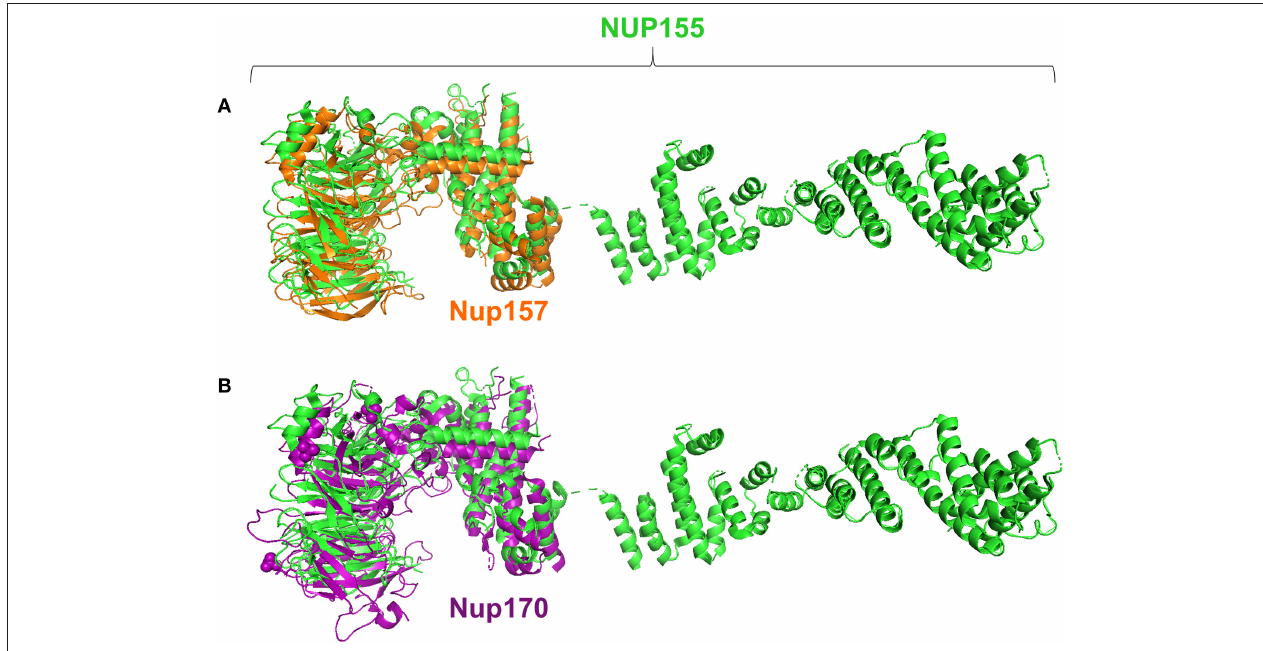
FIGURE 5 | Structure alignments for NUP155 homologs. Analysis revealed that the region in which clustering occurs aligns with the nucleotide binding domains reported for the NUP155 homologs, Nup157 and Nup170 as shown in (A) and (B) , respectively. Specifically, querying the InterPro database to identify conserved regions of NUP155 identified members of the CATH-Gene3D superfamily 1.20.58.1780 that includes the crystallizable fragments of Nup157 and Nup170. Structure alignments for the homologous fragments with NUP155 reported the closest fit for the nucleotide binding domain of Nup157 with NUP155 (RMSD =